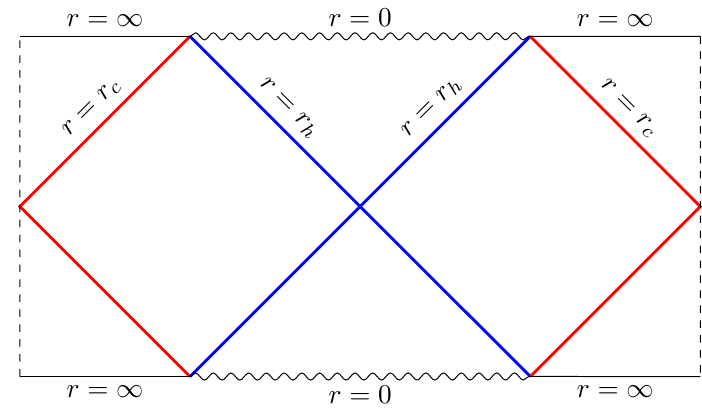
Figure 4 . Penrose diagram of a static, neutral quantum black hole in dS 3